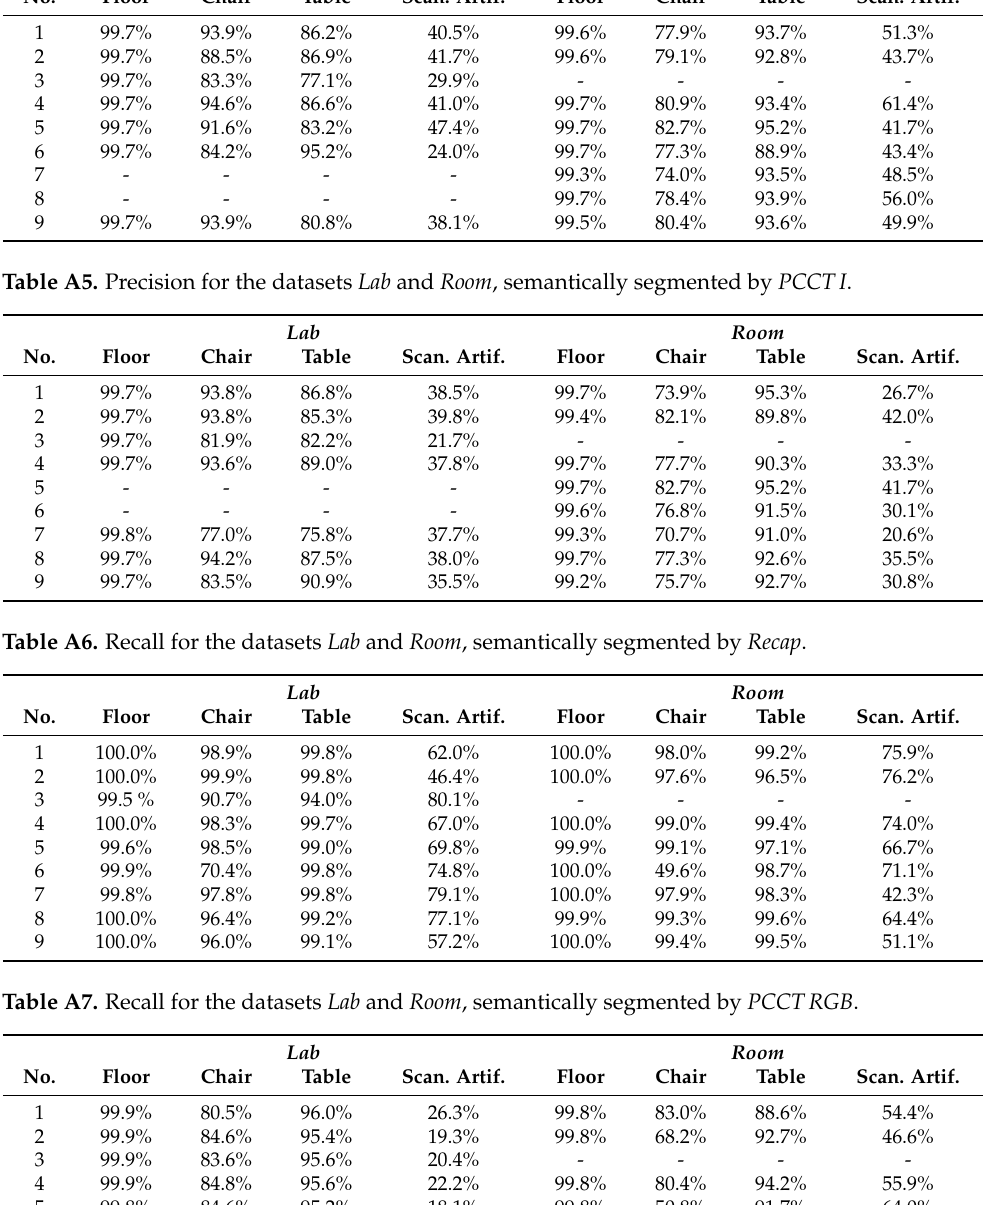
Table A4. Precision for the datasets Lab and Room , semantically segmented by PCCTRGB . Lab Room No. Floor Chair Table Scan. Artif. Floor Chair Scan. Artif.